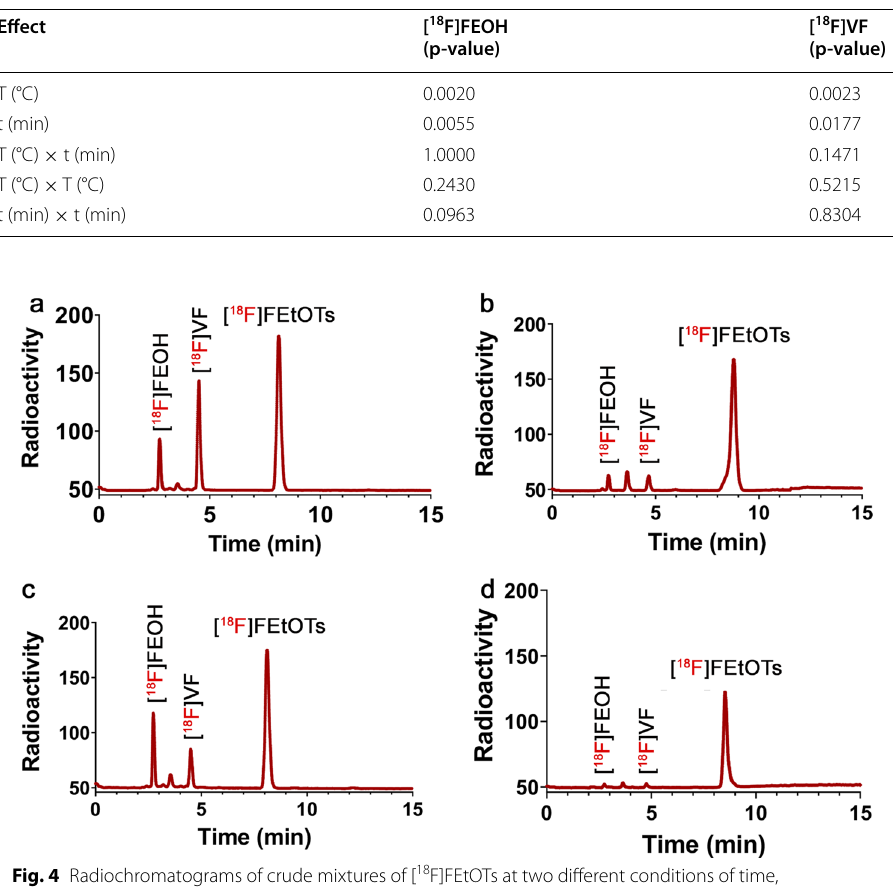
Table 4 P-values obtained from the variance analysis of [ 18 F]FEOH and [ 18 F]VF experimental yields at a 95% confidence